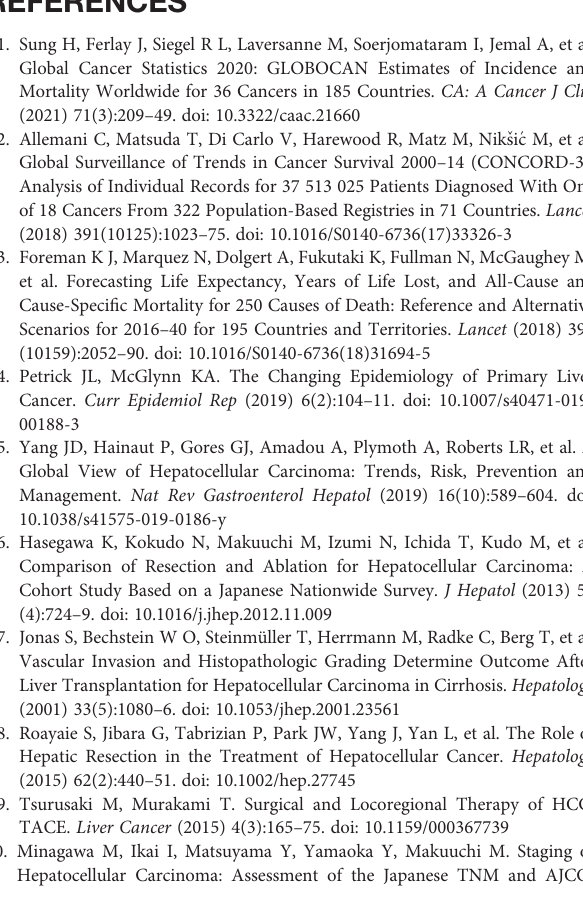
Supplementary Figure 1 | KM survival curves of overall survival based on ANN model risk strati fi cation in HCC patients with different clinical subgroups. (A, B) Patients with different etiology; (C, D) Patients with different AFP levels; (E – J) Patients with different Child-Pugh stage; (H, I) Patients with different inclusion time. Supplementary Figure 2 | Survival analysis based on ANN model risk strati fi cation in HCC patients with different treatments. Supplementary Figure 3 | KM survival curves of disease-free survival based on ANN model risk strati fi cation in HCC patients with training (A) and validation group (B) . Supplementary Figure 4 | Recurrence analysis based on ANN model risk strati fi cation in HCC patients with different treatments. Supplementary Figure 5 | Survival analysis between HCC patients with different Tcellsindifferentetiology (A,B) ,inclusiontime (C,D) andtreatments groups (E – G) . Supplementary Figure 6 | Survival analysis between HCC patients with different CD8 T cells in different etiology (A, B) , inclusion time (C, D) and treatments groups (E – G)